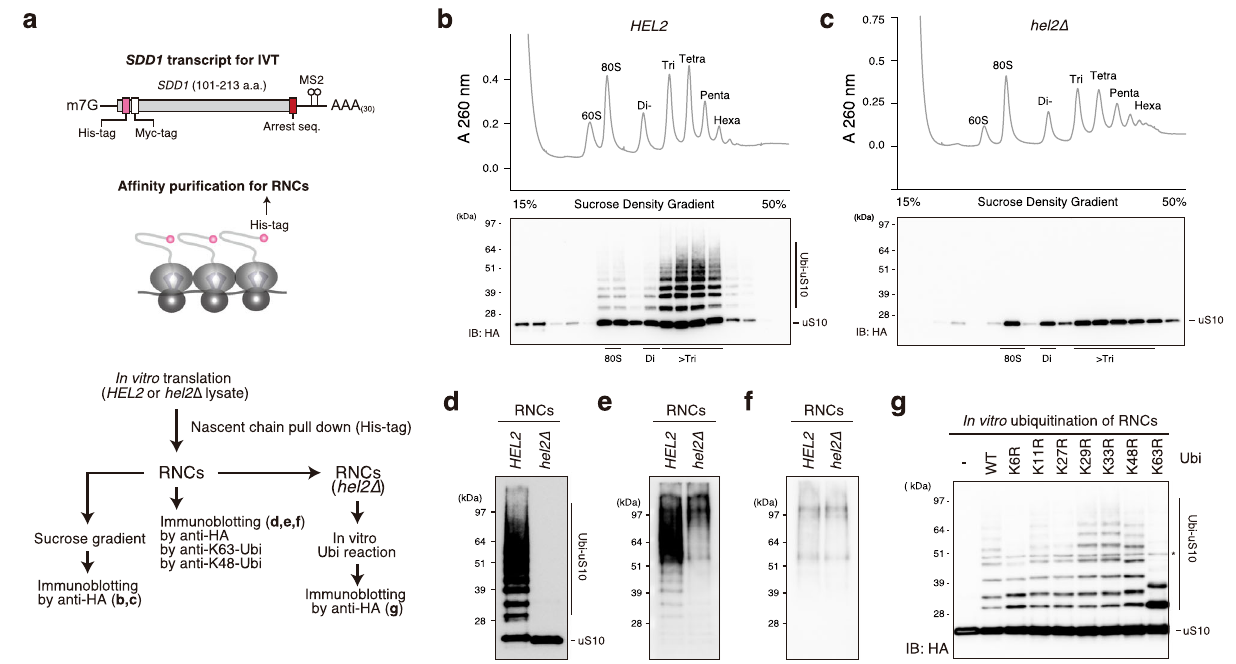
Fig. 1 | In vitro reconstitution of the ubiquitinated colliding ribosomes. a Schematicdrawingofthe SDD1 modelmRNAusedintheinvitrotranslation(IVT) assay(Top).Schematicoftheinvitroexperiments(bottom). b , c Thepuri fi edRNCs intheIVTreactionusing HEL2 -containingor hel2 -knockout( hel2 Δ )IVTextractwere separated by sucrose density gradient centrifugation and detected by UV absor- banceatawavelengthof260nm.HA-taggeduS10ineachfractionwasdetectedby immunoblotting using an anti-HA antibody. Immunoblotting of puri fi ed RNCs